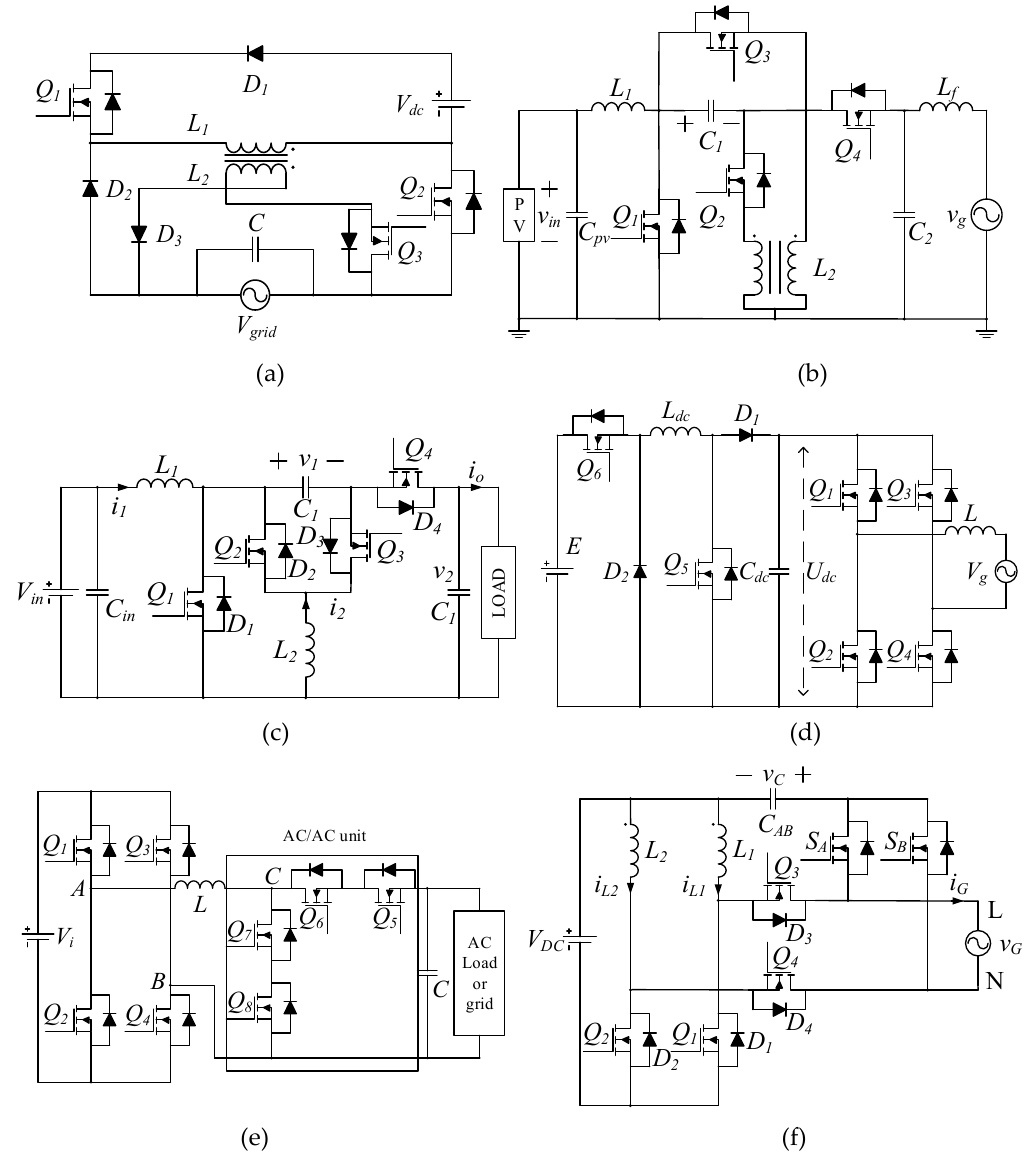
Figure 1. Prior-art, single-stage, buck-boost inverters: ( a ) [5], ( b ) [6], ( c ) [7], ( d ) [12], ( e ) [15], and ( f ) [20].